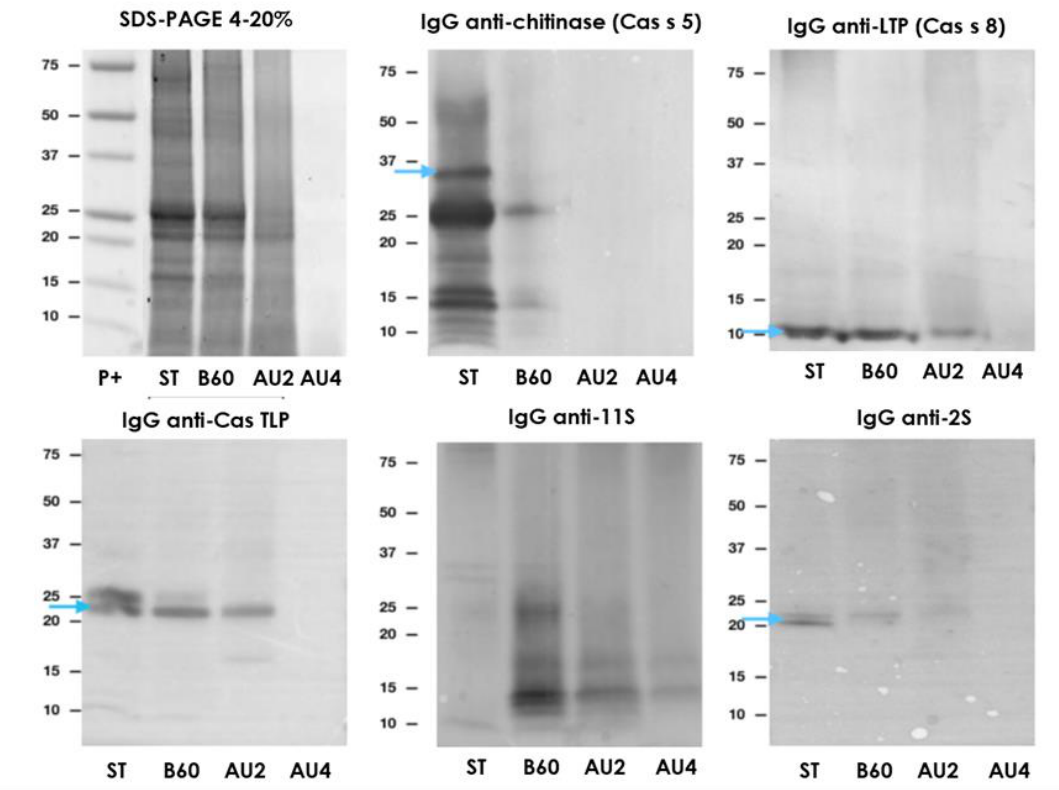
Figure 6. SDS-PAGE and IgG anti-chitinase, anti-lipid transfer protein (anti-LTP), anti TLP, anti-11S, and anti-2S immunoblots analysis of control (ST), boiled 60 min (B60) and autoclaved at 121 ◦ C at 30 min (AU2) and 138 ◦ C 30 min (AU4) chestnut samples. Molecular weight marker was Precision Plus (P+).